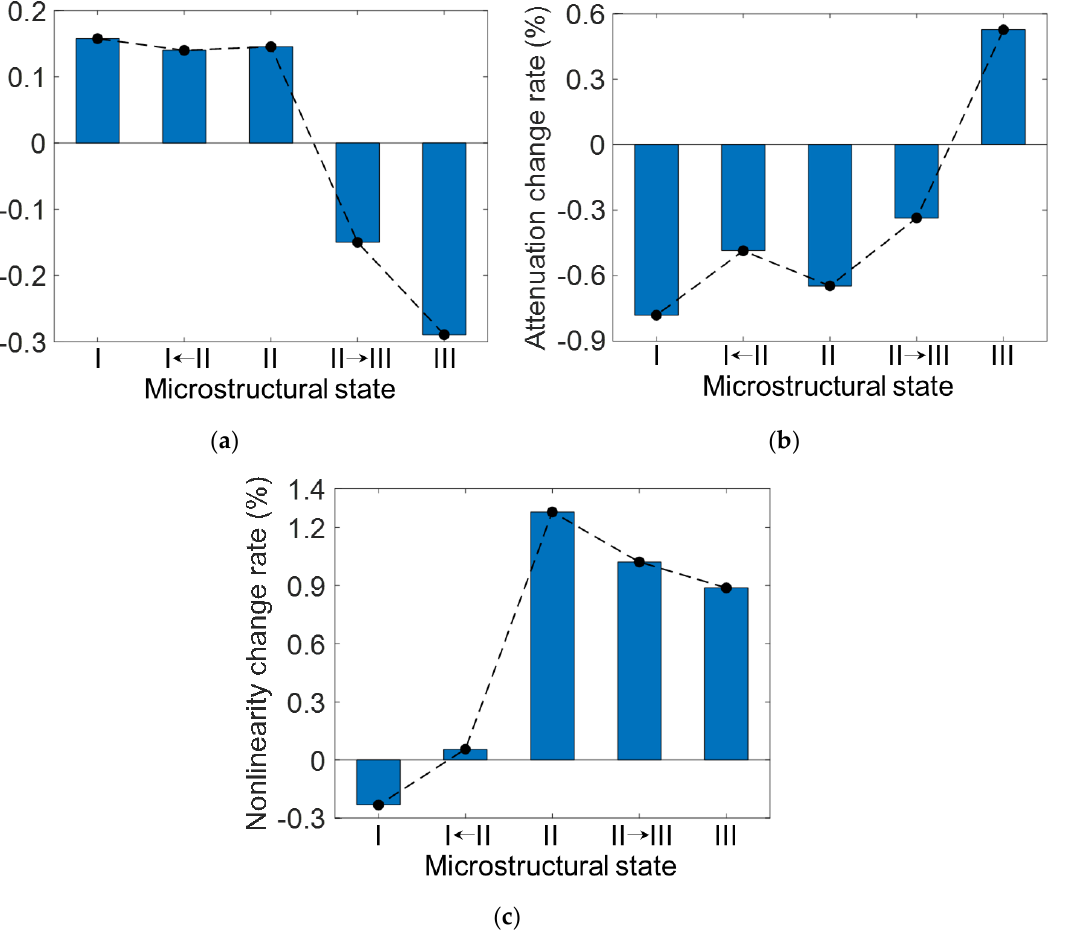
Figure 11. Change rates for the ( a ) 𝑣 , ( b ) 𝑎 , and ( c ) 𝛽′ parameters measured when State II transitions to State I and III.